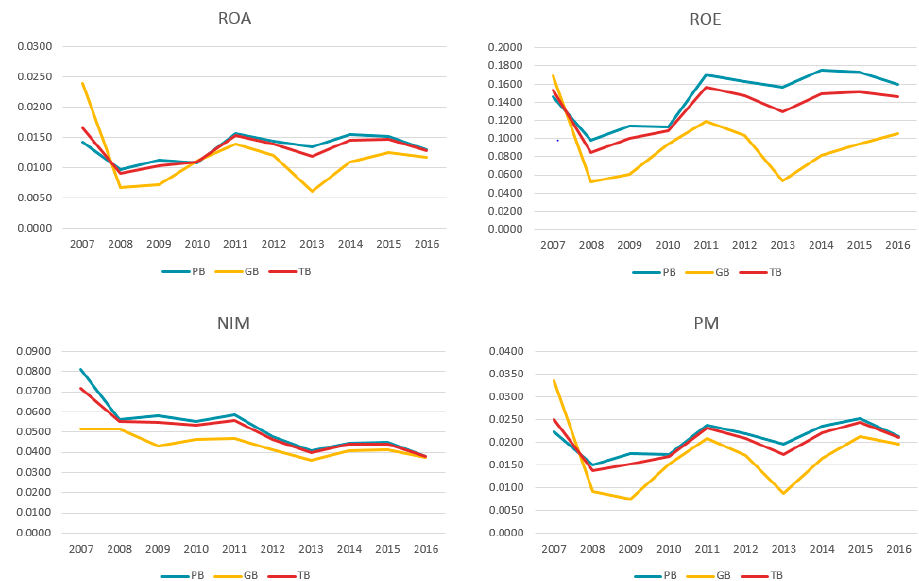
Figure 1. Trend in the profitability of Pakistani banks (2007–2016). PB, private banks; GB, government banks; TB, total banks.